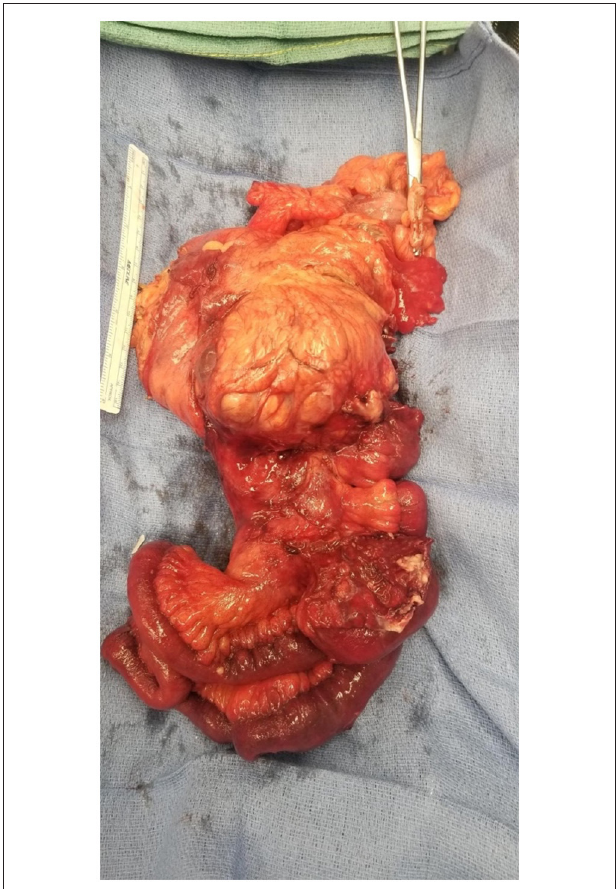
FIGURE 6 | Gross pathology demonstrating mass with intimate association to sigmoid colon with involved mesentery and ileum resection. Posterior view.